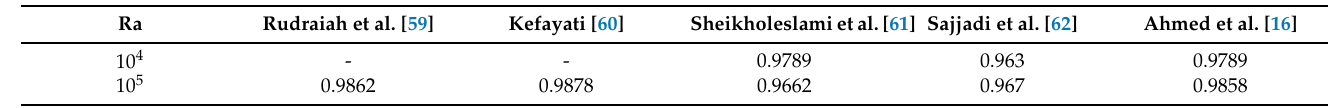
Table 3. Obtained R 2 in each validation with literature individually. Detected outliers were removed for the correlation